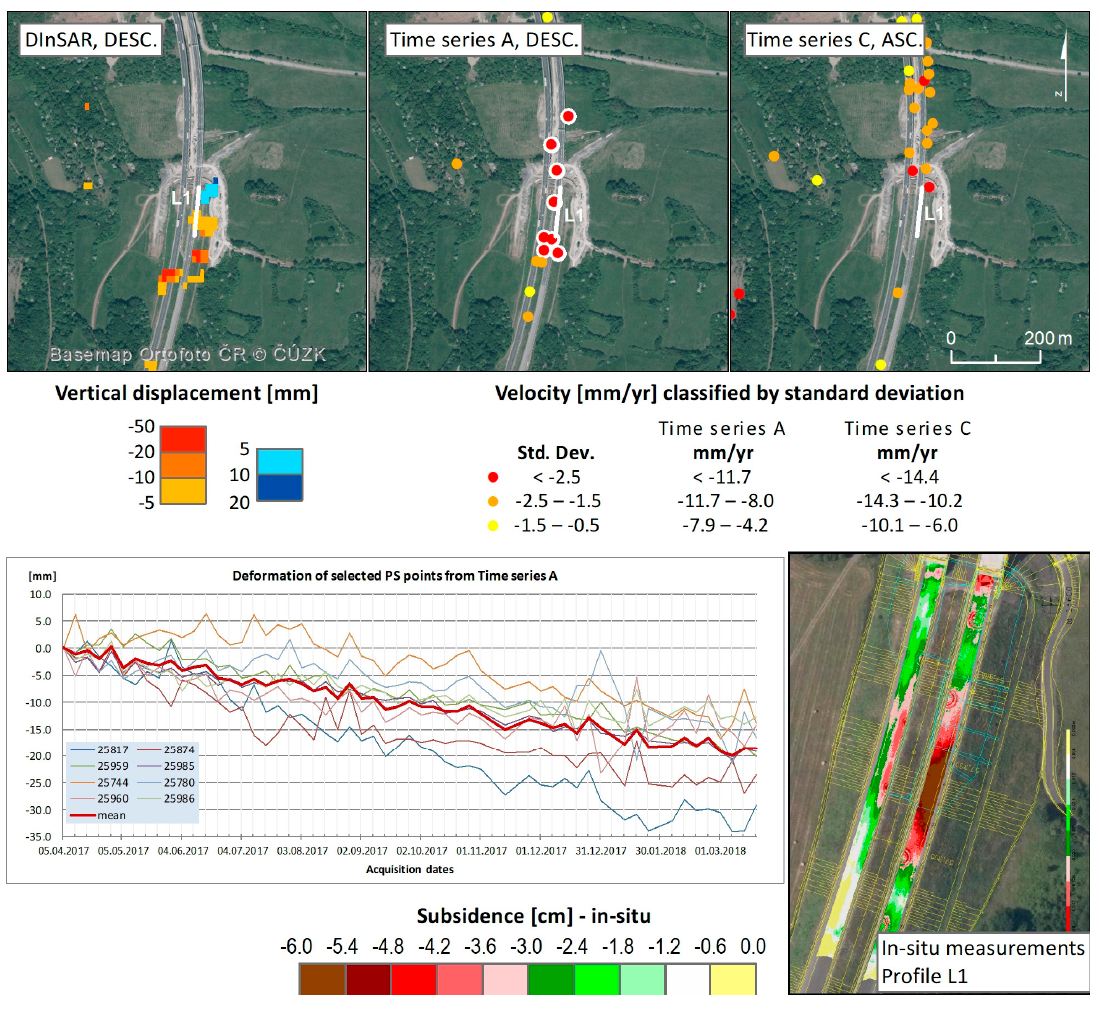
/ uplift in area no. 3.